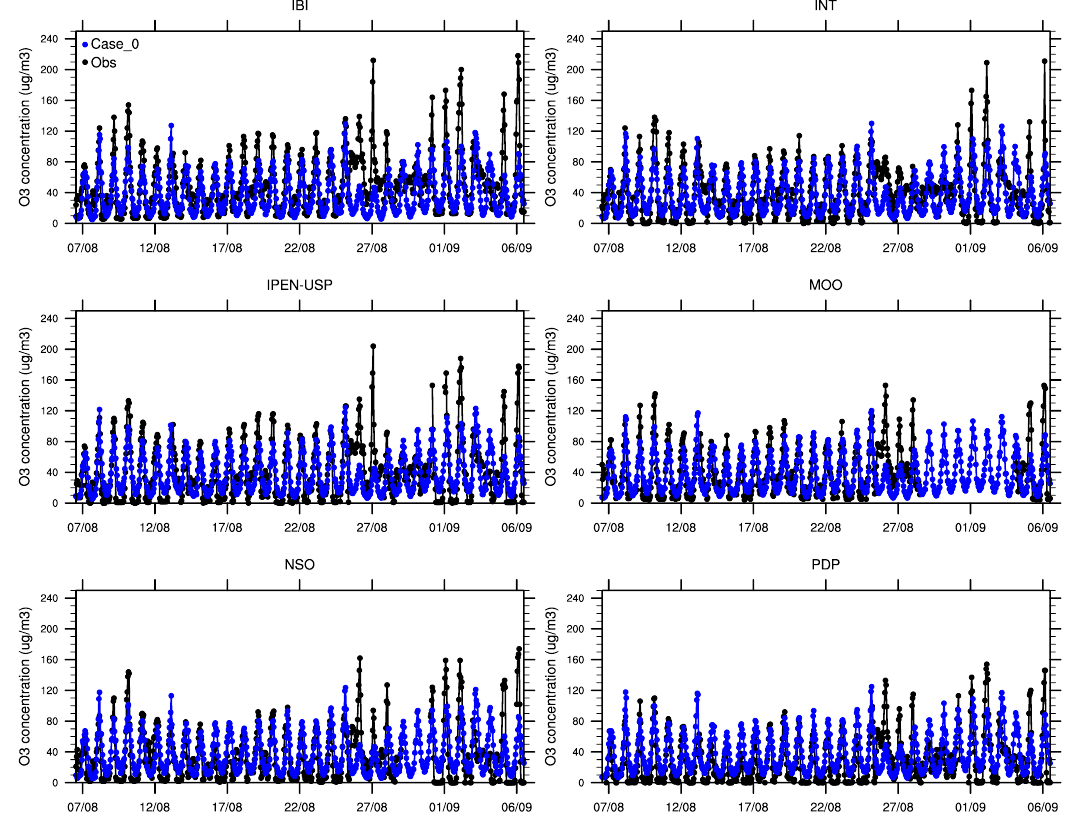
Figure 9. The observed and predicted hourly variations of O 3 concentrations at six sites in SPMA for the 3km modelling domain.